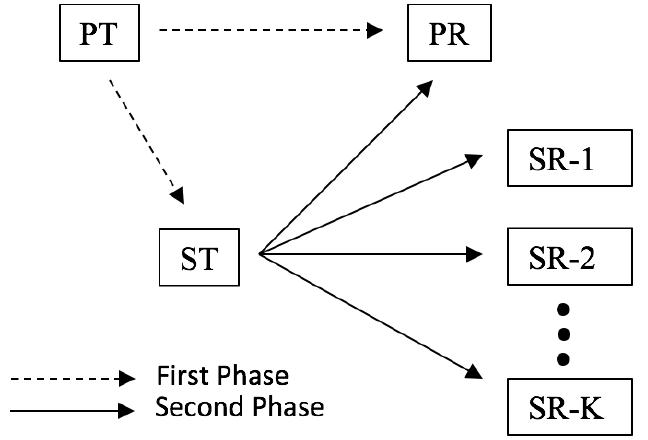
Figure 1. A depiction of a NOMA-based spectrum-sharing CRN with two transmission